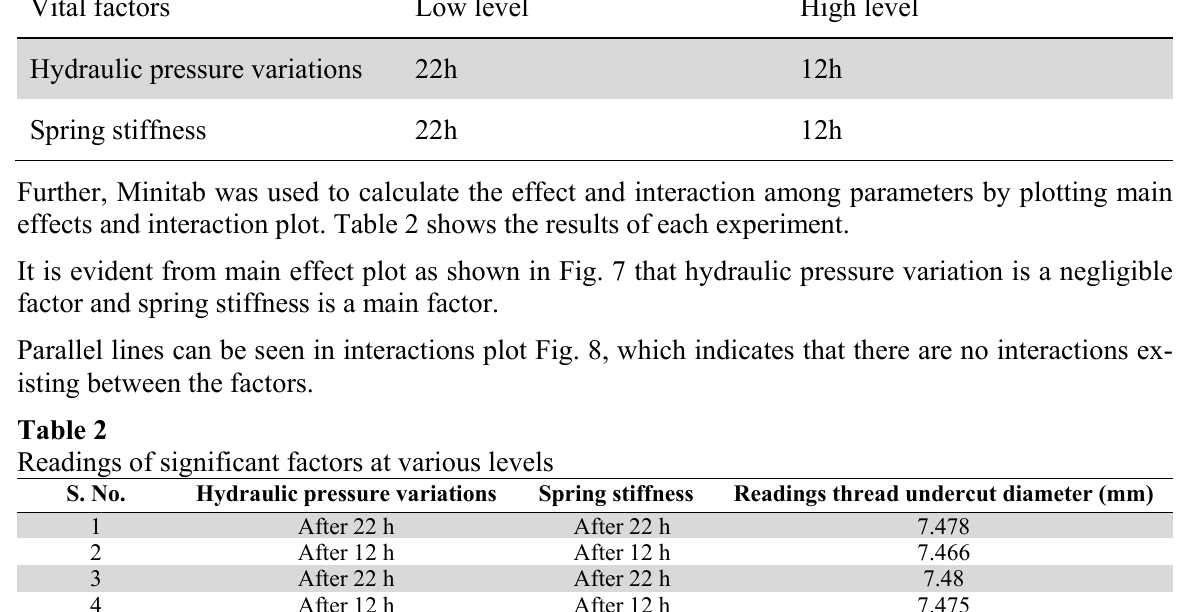
Significant vital factors for thread undercut diameter variations Vital factors Low level High level Hydraulic pressure variations 22h 12h Spring stiffness 22h 12h